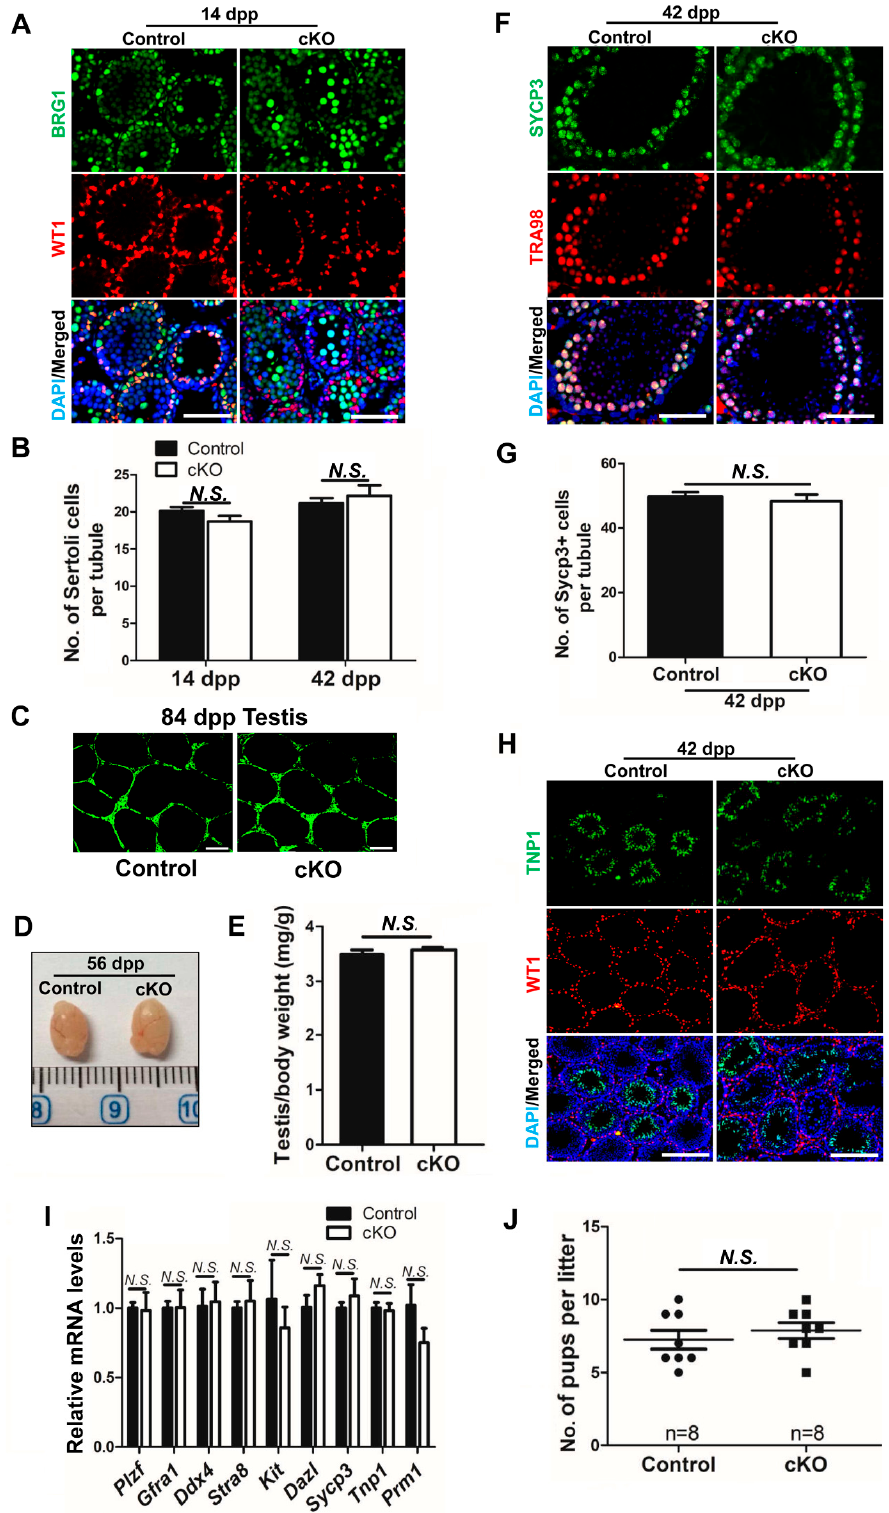
Figure 4. Complete Brg1 deletion does not a ff ect Sertoli cell development and spermatogenesis. ( A ) Expression of BRG1 and WT1 was examined with IHF in control and cKO testes from mice at 14 dpp. Scale bars, 100 µ m. ( B ) Quantification of WT1 + Sertoli cells per tubule in the transverse section of the testes from 14 dpp and 42 dpp mice. Data represent mean ± SEM. n = 7 for 14 dpp and n = 6 for 42 dpp mice. ( C ) Integrity of the BTB was assessed in testes from cKO mice and their littermate controls, as displayed by a biotin tracer (Alexa Fluor 488 fluorescence). Scale bars: 100 µ m. ( D ) Representative images of testes from control and cKO mice at 56 dpp. (E) The ratio of testis / body weight was examined in cKO mice and their control littermates at 42 dpp. Data are presented as mean ± SEM. ( F ) Germ